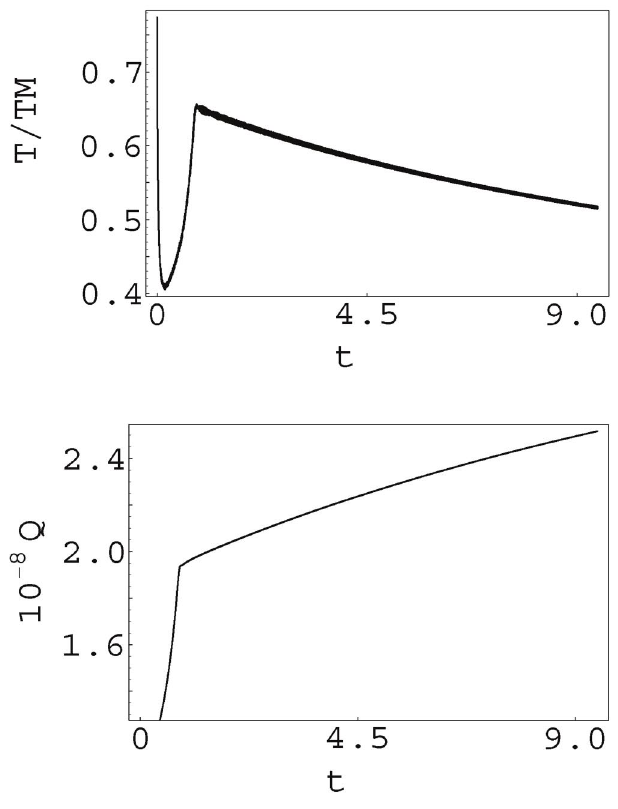
FIG. 7. Variation of the temperature (in units of T charge Q with time in seconds for the same case as in Fig.